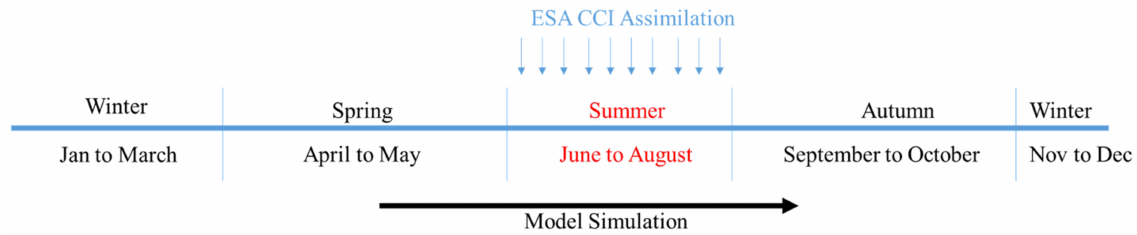
Figure 3. Time frame indicating the assimilation window of ESA CCI